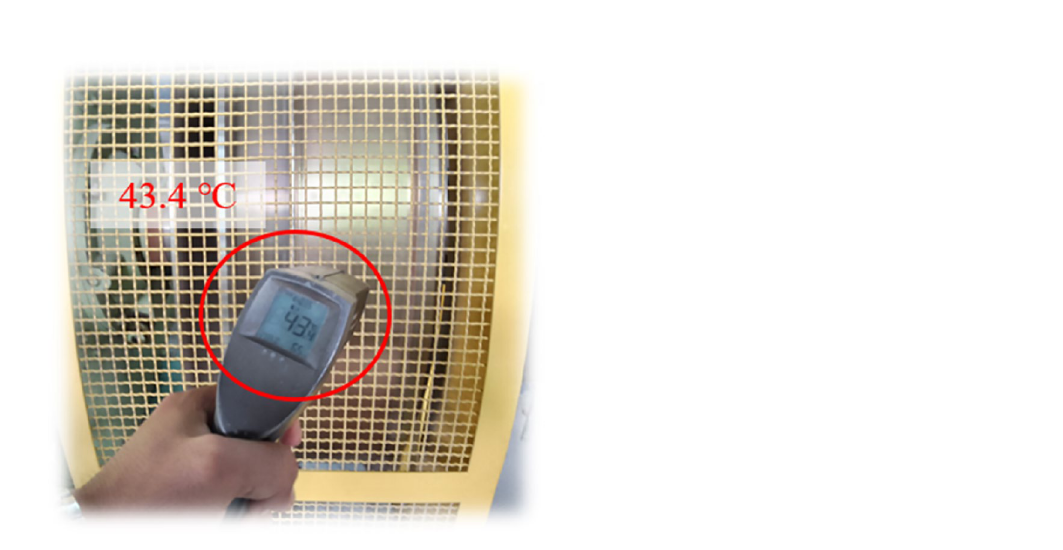
Figure 7. Temperature test of the cooling